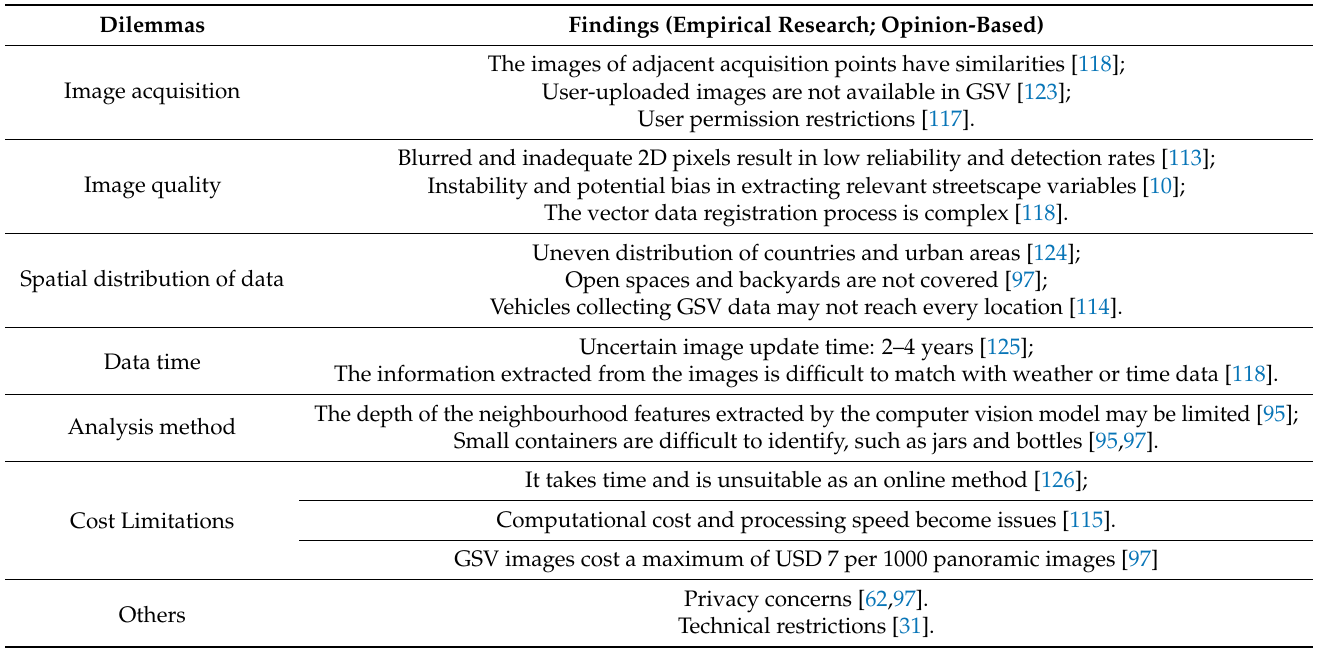
Table 5. Summary of dilemmas when using SVI in the built environment.